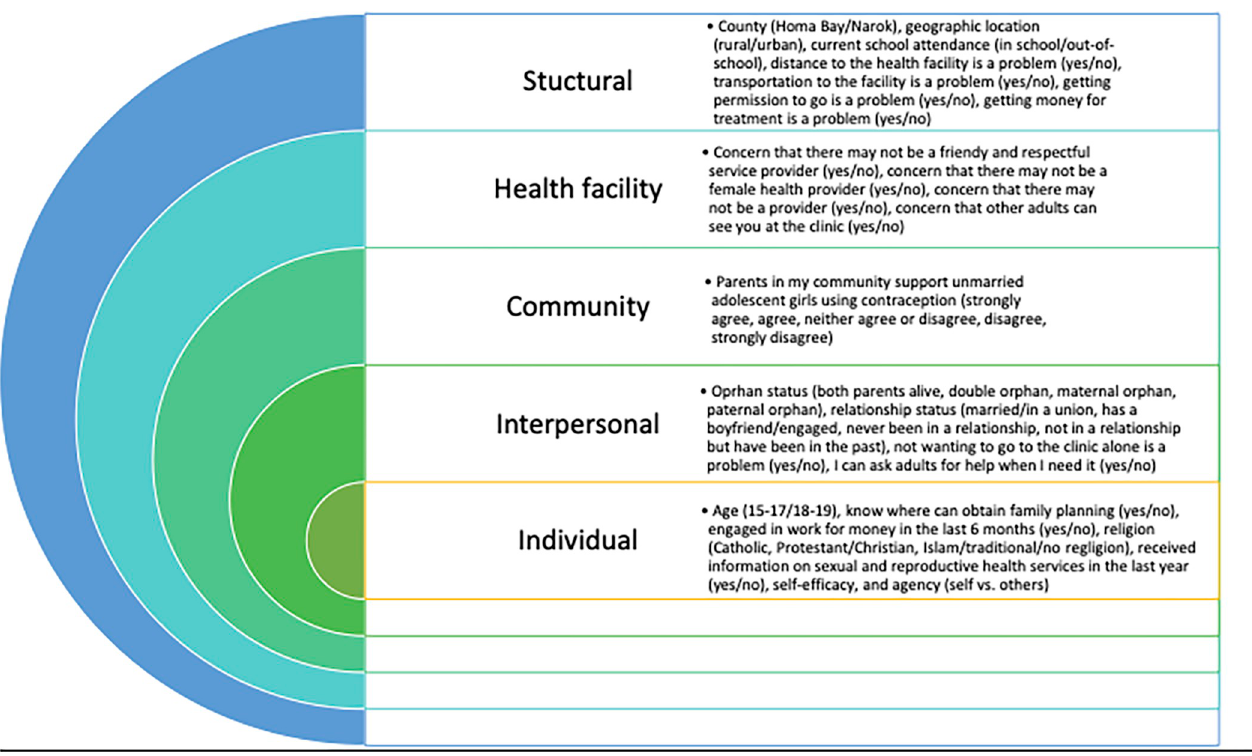
Fig 1. Variables selected as factors influencing sexual and reproductive health utilization across the social-ecological model levels and included in analyse.